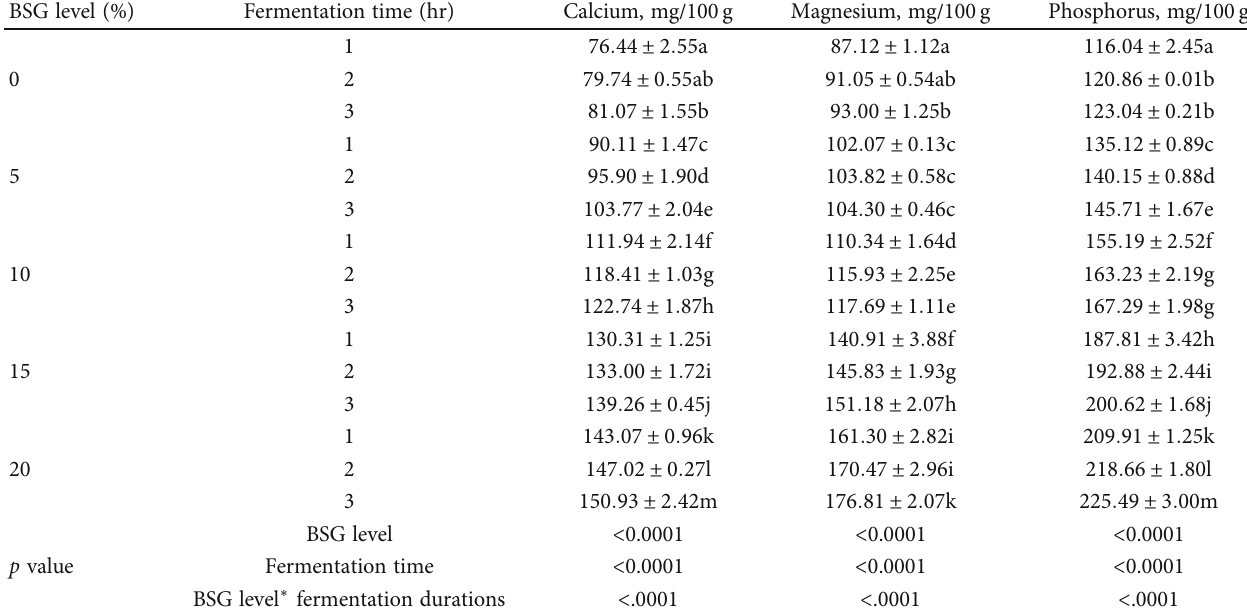
Table 5: The mineral content (calcium, magnesium, phosphorus) of BSG incorporated bread. BSG level